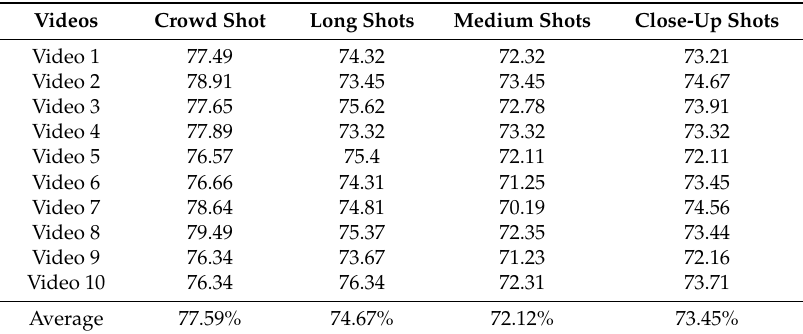
Table 4. Classification accuracy using SVM (linear kernel) with LTrP